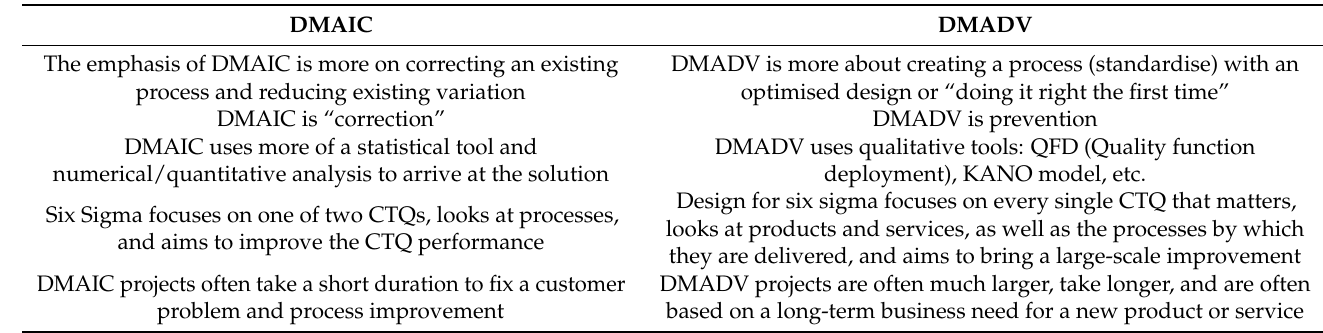
Table 1. Difference between DMAIC and DMADV